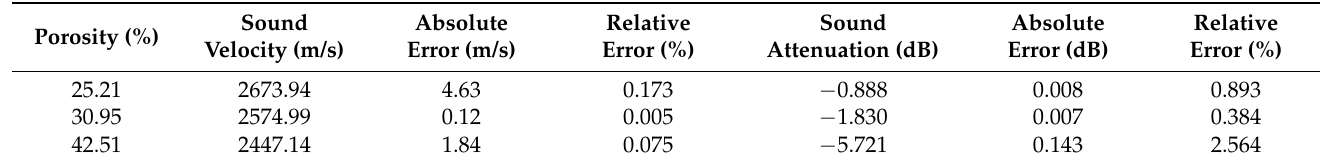
Table 4. The sound velocity prediction results of the simplified Biot model and the sound attenuation prediction results of the simplified BISQ